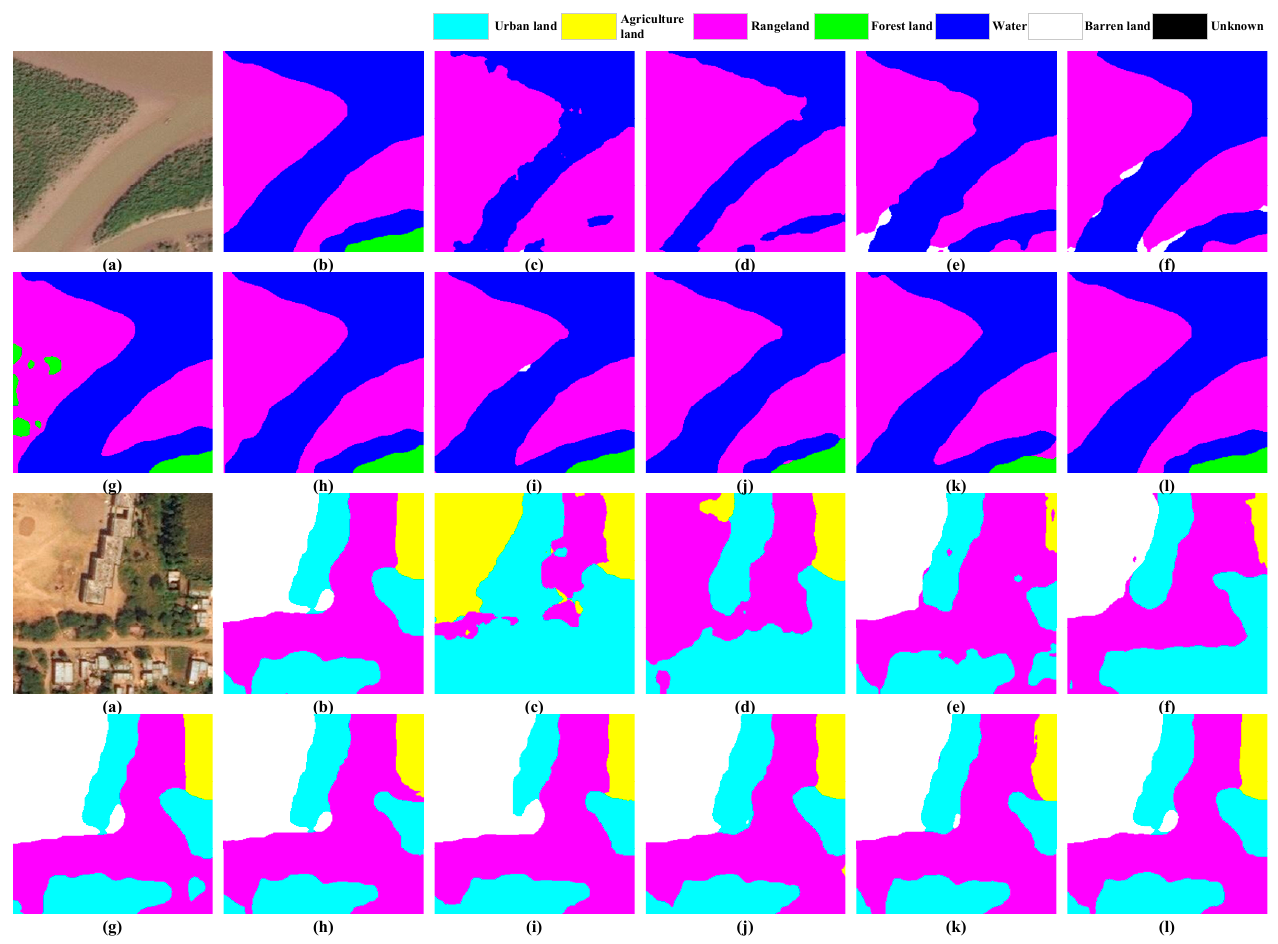
Figure 10. Visualizations of predictions of the test set of the DeepGlobe benchmark. ( a ) Input image, ( b ) ground truth, ( c ) FCN-8s, ( d ) SegNet, ( e ) U-Net, ( f ) DeepLab V3+, ( g ) CBAM, ( h ) DANet, ( i ) ResUNet-a, ( j ) SCAttNet, ( k ) HCANet, ( l ) ICTNet. Table 5. Results of the ablation study of DFA. The accuracy is in the form of mean F1-score/OA. Models Vaihingen Potsdam DeepGlobe ICTNet